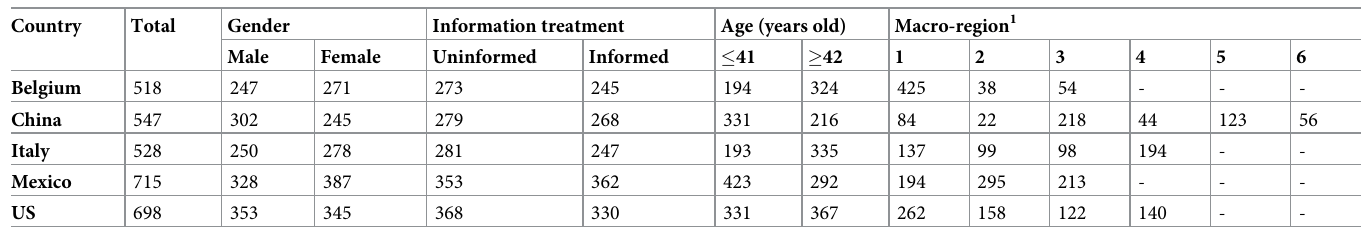
Table 1. Sample characteristics per country under